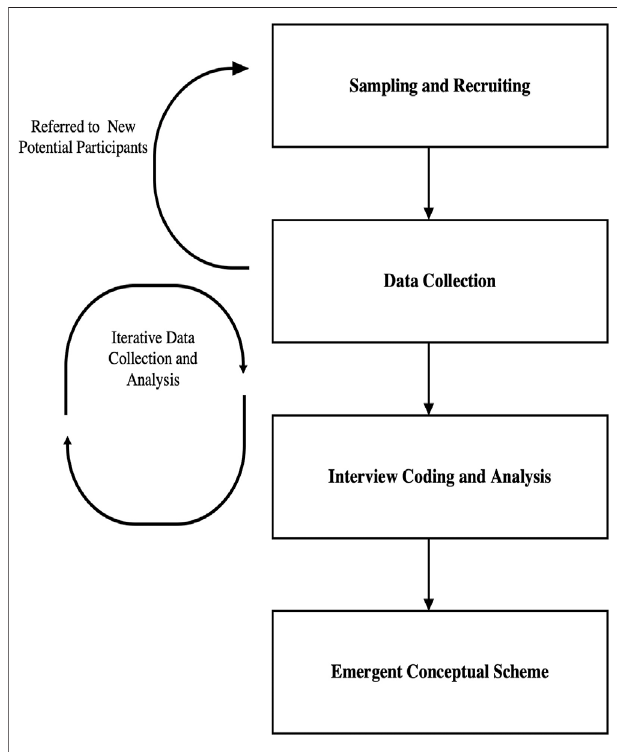
FIGURE 1 | Research procedure. The research procedure started with sampling and recruiting study participants before conducting interviews. The interviews were then individually coded before all quotes belonging to one theme were grouped. From some interviews new study participants were identi fi ed. The interview and analysis process proceeded iteratively until theoretical saturation was reached. Finally, a conceptual scheme was formulated from the themes that emerged from the interview